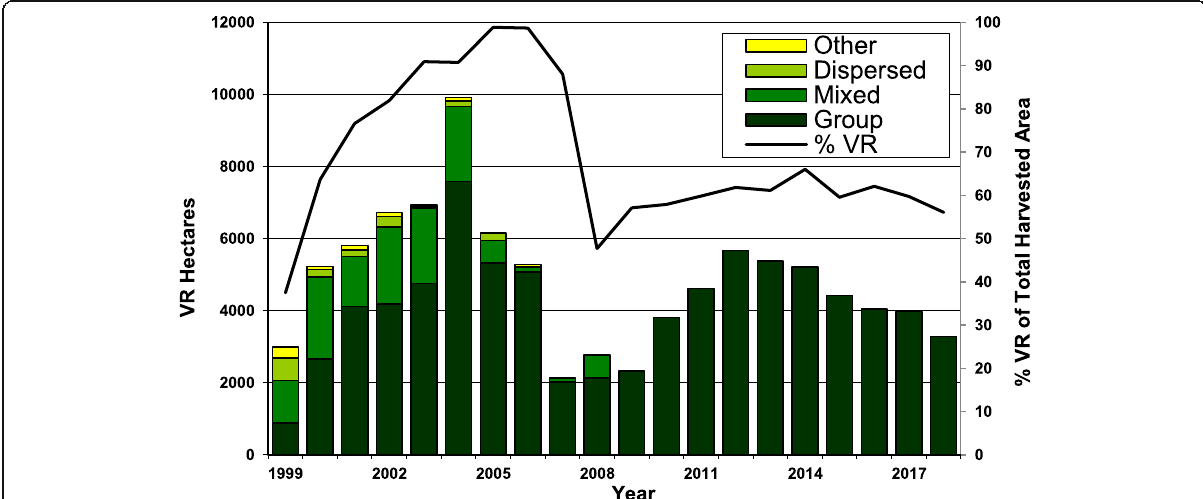
Fig. 1 Percent of total harvested area using variable retention (line) and area harvested (bars) using different variable retention types over 20 years by MacMillan Bloedel/Weyerhaeuser/Cascadia (1999 – 2006) and Western Forest Products (2007 – 2018) in BC Coastal forest operations. Total area through 2004 includes private lands (now Island Timberlands). Group = aggregated retention with groups predominantly 0.25 ha or larger; Dispersed = single trees or small clusters of trees spread across a cutblock; Mixed = both group and dispersed retention in the same cutblock; Other = patch cut, shelterwood or selection systems (with long-term reserves). Retention type was not tracked after 2008 because nearly all VR was aggregated retention